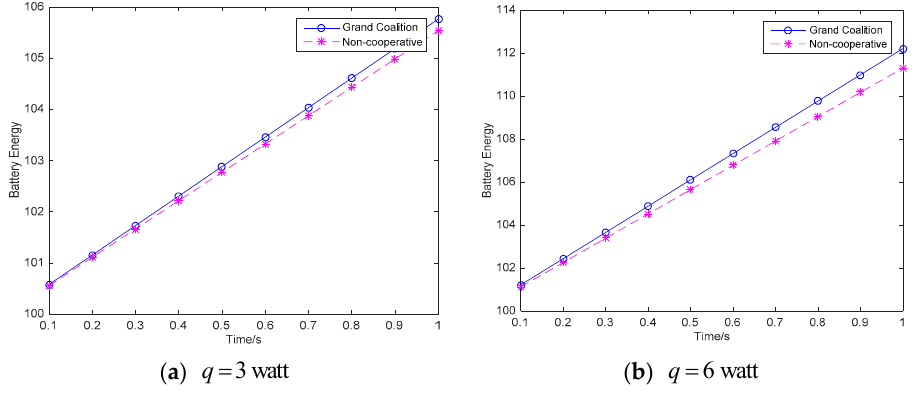
Figure 6. Battery energy variation.